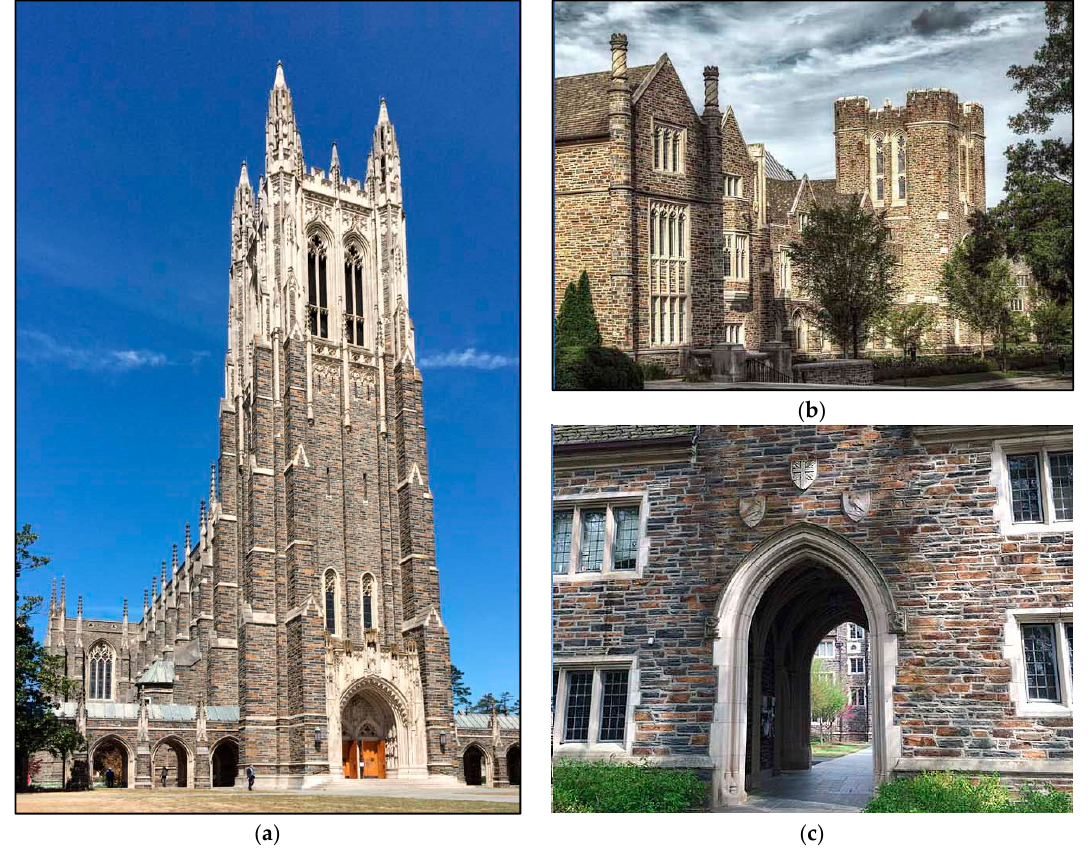
Figure 8. The Architecture of Duke University’s West Campus, Durham, NC. ( a ) Duke Chapel (1932); ( b ) Residential Quadrangle and Tower; ( c ) Gothic Archway and Ornament. Image Credit: © 2019 Jeremy Kargon.